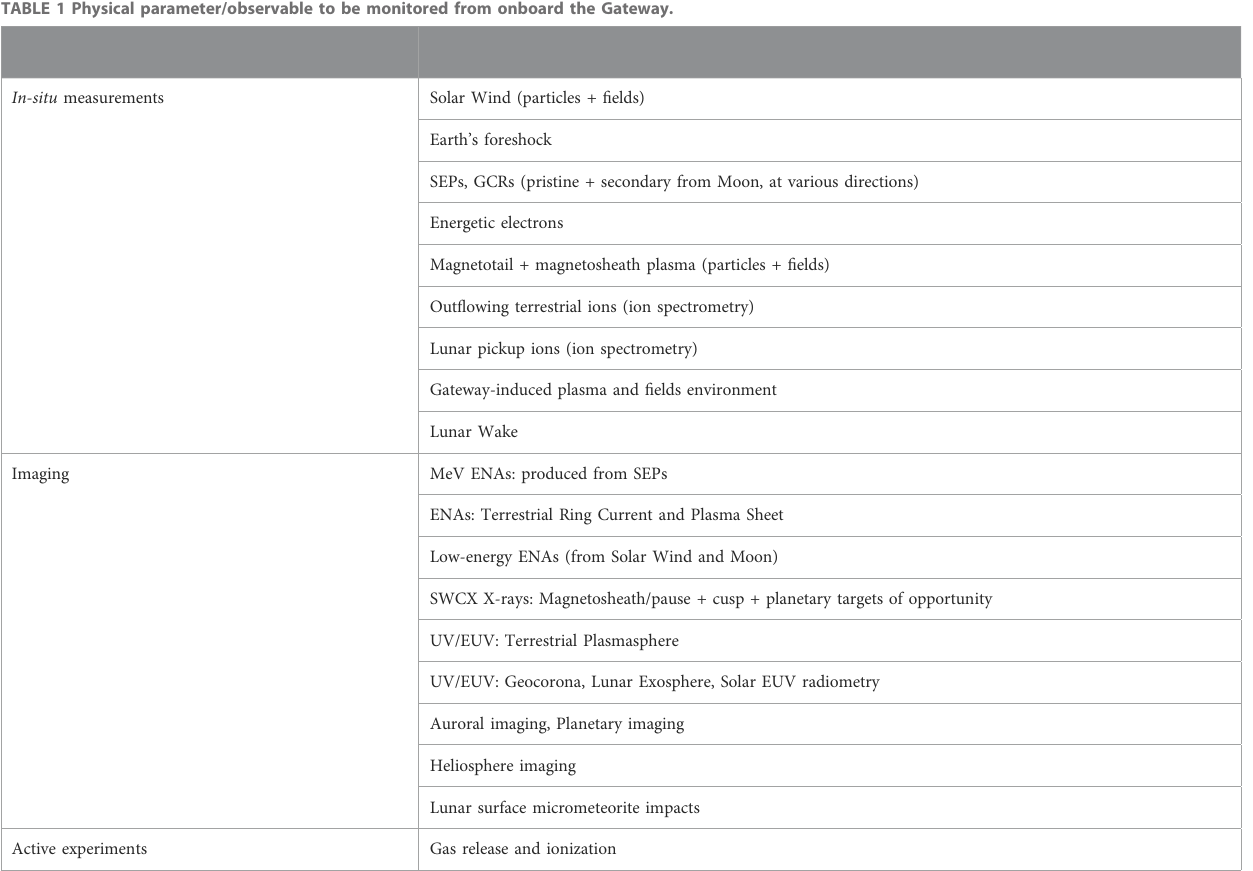
TABLE 1 Physical parameter/observable to be monitored from onboard the Gateway.